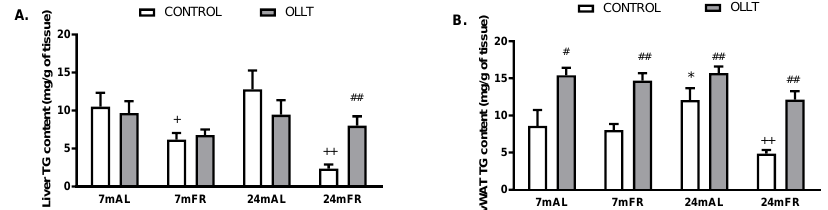
Figure 6. Content of triglycerides (TG) in liver ( A ) and visceral adipose tissue ( B ) in 7- and 24-month-old rats fed ad libitum (AL) or food restricted (FR), before (CONTROL) and after an oral lipid loading test (OLLT). Results are the mean ± SEM of 8 – 10 rats per group, conducted in duplicates. Unpaired Student’s t -test, * p < 0.05 compared to the 7-month-old rats under the same feeding protocol; + p < 0.05, ++ p < 0.0001 compared to the age-matched ad-libitum-fed rats; # p < 0.05, ## p < 0.0001 compared to the basal levels before a fat load of the age-matched rats under the same feeding protocol.